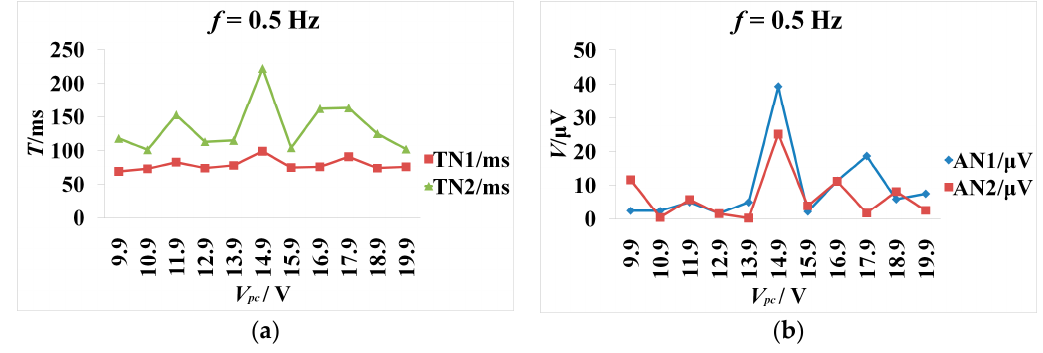
Figure 2. CCEPs change along with the varying stimulation intensity. The frequency is 0.5 Hz. V oc = 5 V. V pc = 9.9–19.9V. The peak-peak amplitude and offset of square voltage pulse are 3.3 and 1.65 V. The pulse width is 0.5 ms. ( a ) The latency change of N1 and N2 (negative surface deflections) along with increasing V pc . TN1 and TN2 represents the latency of N1 and N2; ( b ) The amplitude of N1 and N2 change along with the increasing V pc . AN1 and AN2 represent the amplitude of N1 and N2, respectively.